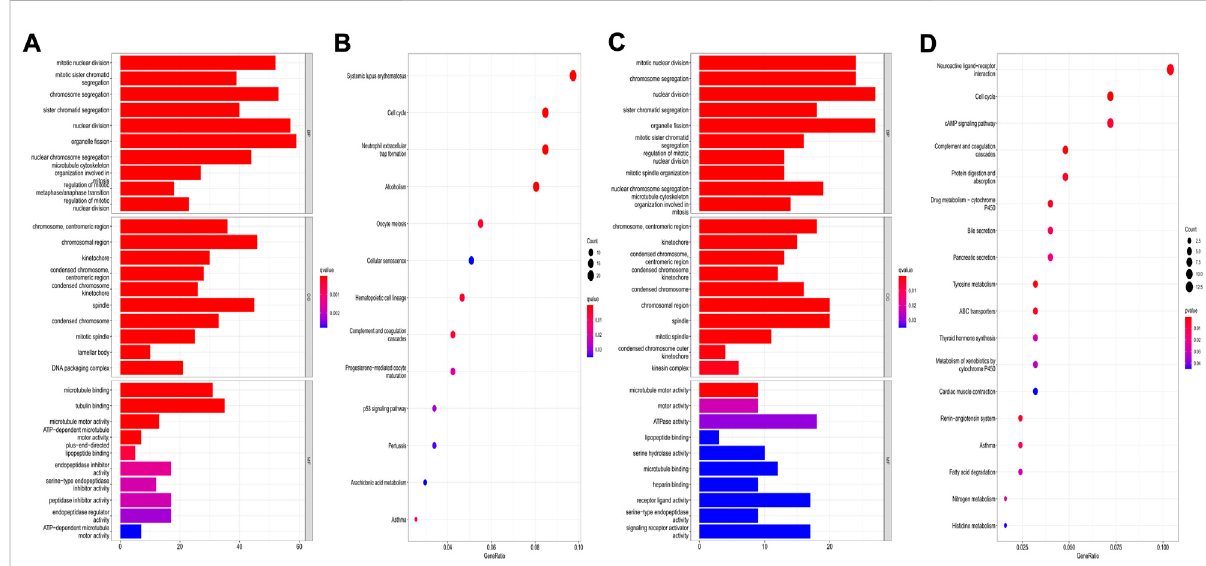
FIGURE 11 Functional analysis based on the DEGs between the two risk groups. (A,B) GO bar plot graph and KEGG bubble plot for the DEGs in the training cohort; (C,D) GO bar plot graph and KEGG bubble plot for the DEGs in the validation cohort. (q-value: the adjusted p value).